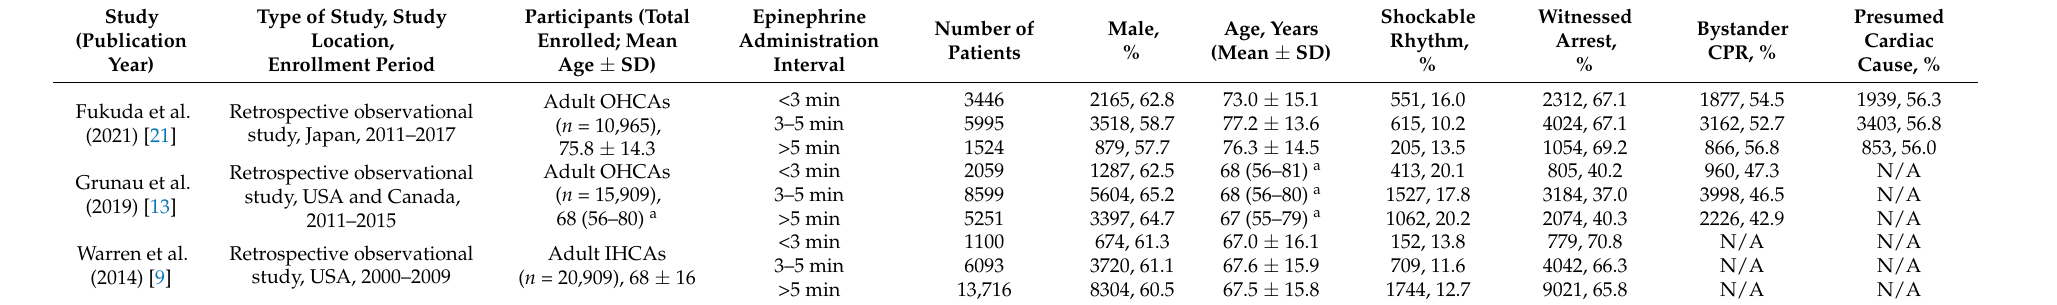
Table 1. Characteristics of included studies.